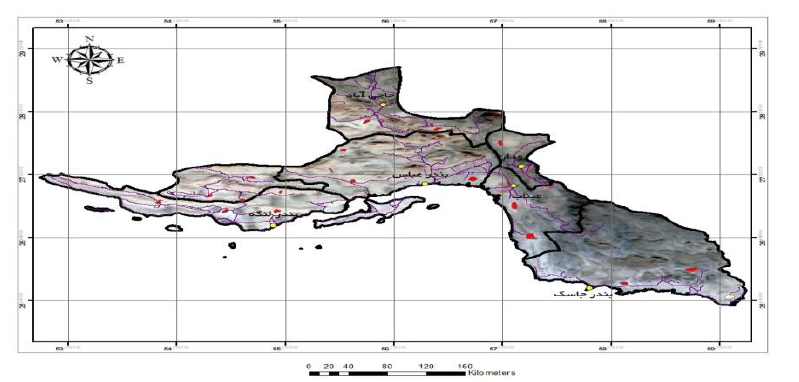
Diagram 1- final diagram of mixed indicators for landfill establishment in Hormozgan